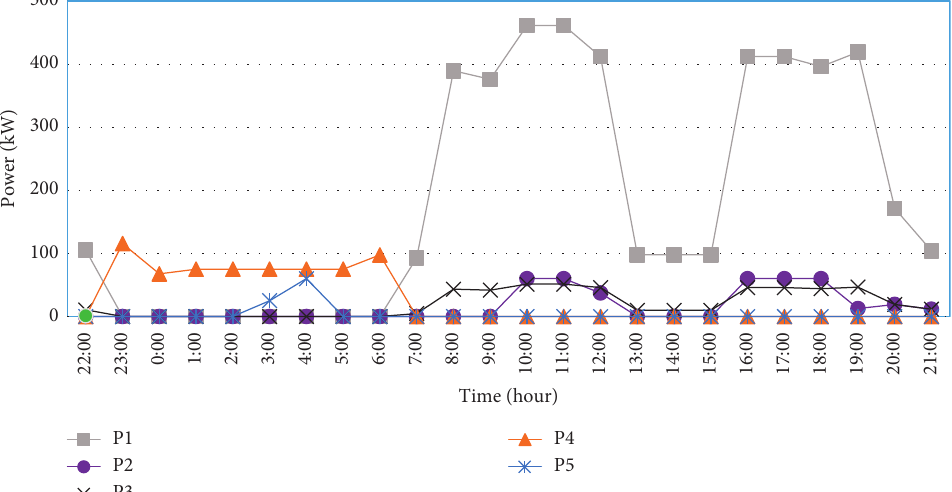
Figure 9: Hybrid energy management system in case 4. P 1 and P 4 illustrate the power flow from the fuel cell and cold ironing to feed the load and P 2 and P 5 demonstrate the power flow from the fuel cell and cold ironing to charge the battery bank and the P 3 is discharge power of the battery.